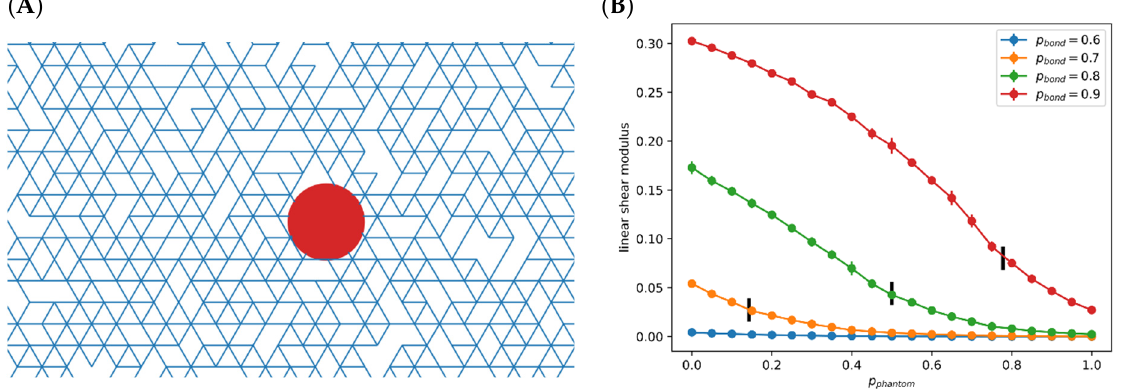
Figure 2. ( A ) A local region of the diluted triangular lattice. The red circle represents an embedded bead used for measuring local stiffness. ( B ) Linear shear modulus for different p phan and p bond , black bars represent the point where average connectivity equals to 4.